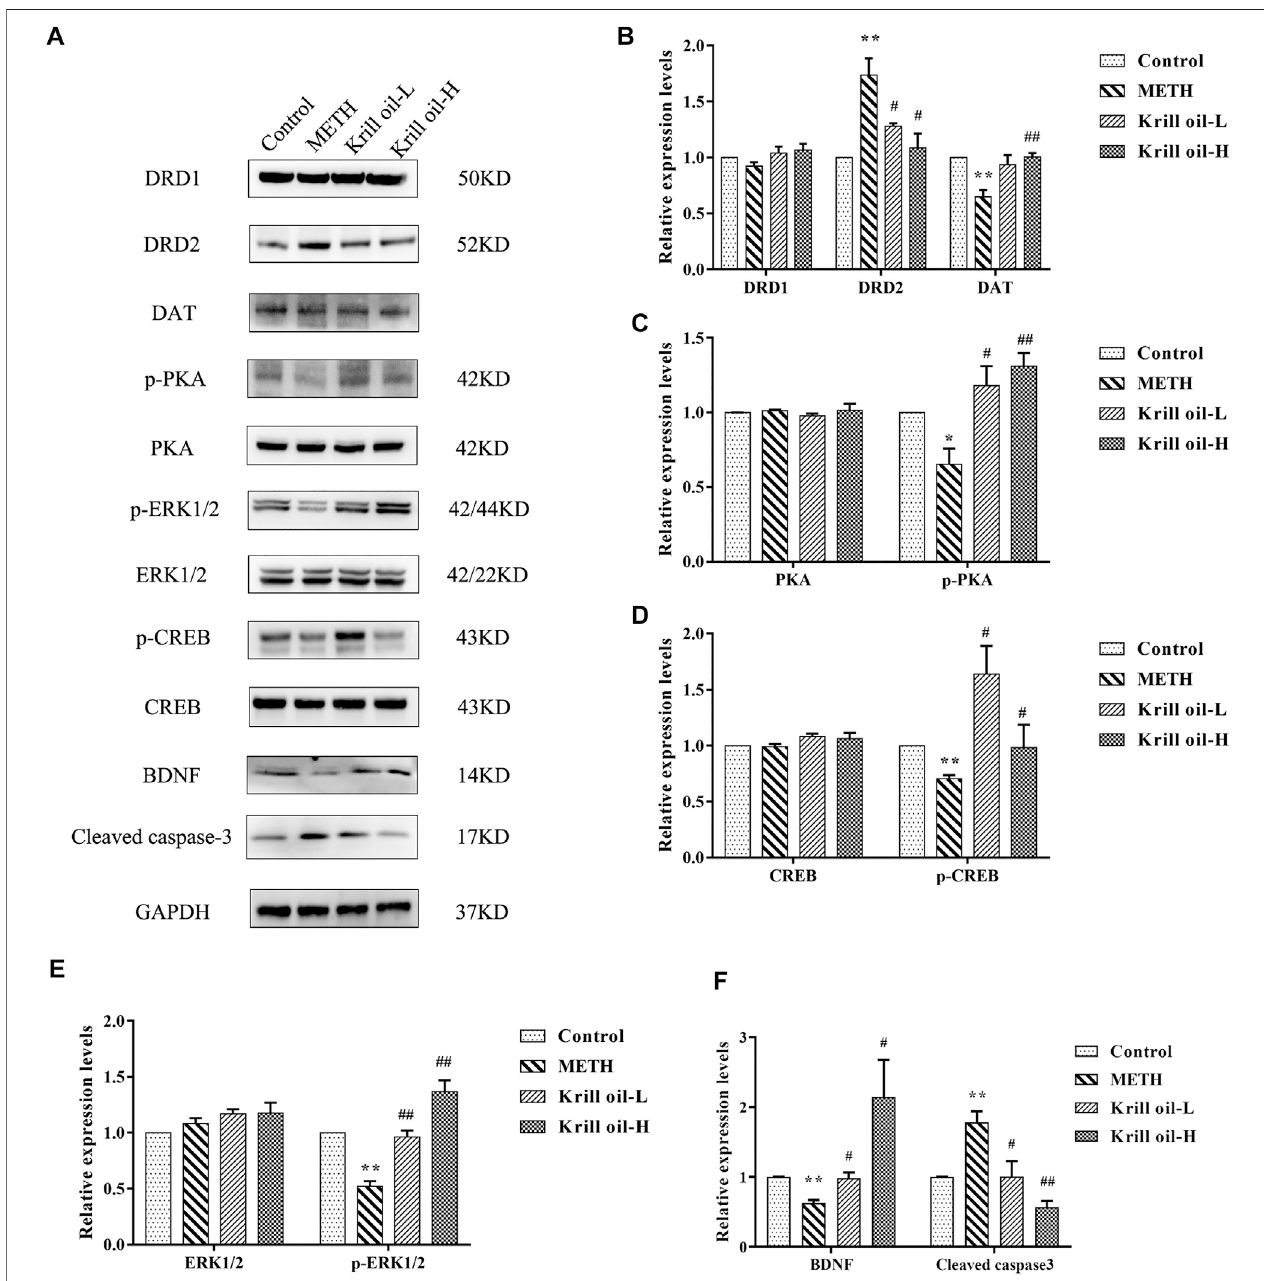
FIGURE7| RelativeexpressionsofrelatedproteinsinthehippocampusofmicetreatedwithMETHand/orkrilloil. (A) RepresentativeimagesofDRD1,DRD2,DAT, p-PKA, PKA, p-ERK1/2, ERK1/2, p-CREB, CREB, BDNF, and cleaved caspase-3. (B) Statistical results of DRD1, DRD2, and the DAT protein. (C) Statistical results of the p-PKA and PKA protein. (D) Statistical results of the p-CREB and CREB protein. (E) Statistical results of the p-ERK1/2 and ERK1/2 protein. (F) Statistical results of the mature BDNF protein and cleaved caspase-3. Data were presented as means ± SEM. * p < 0.05, ** p < 0.01 compared to the control group, # p < 0.05, ## p < 0.01 compared to the METH